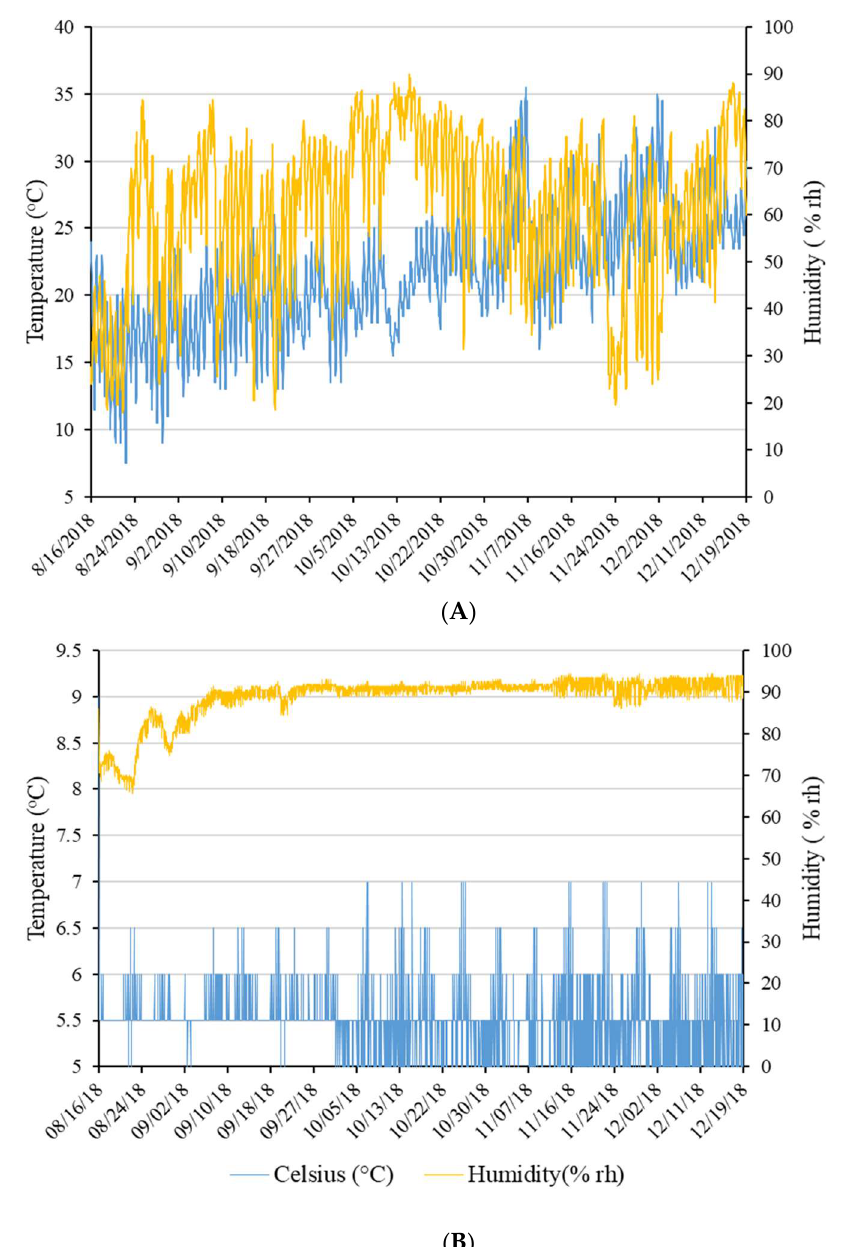
Figure 1. Changes in temperature and relative humidity in the closed shed ( A ) and cool room ( B ) during the experiment period.